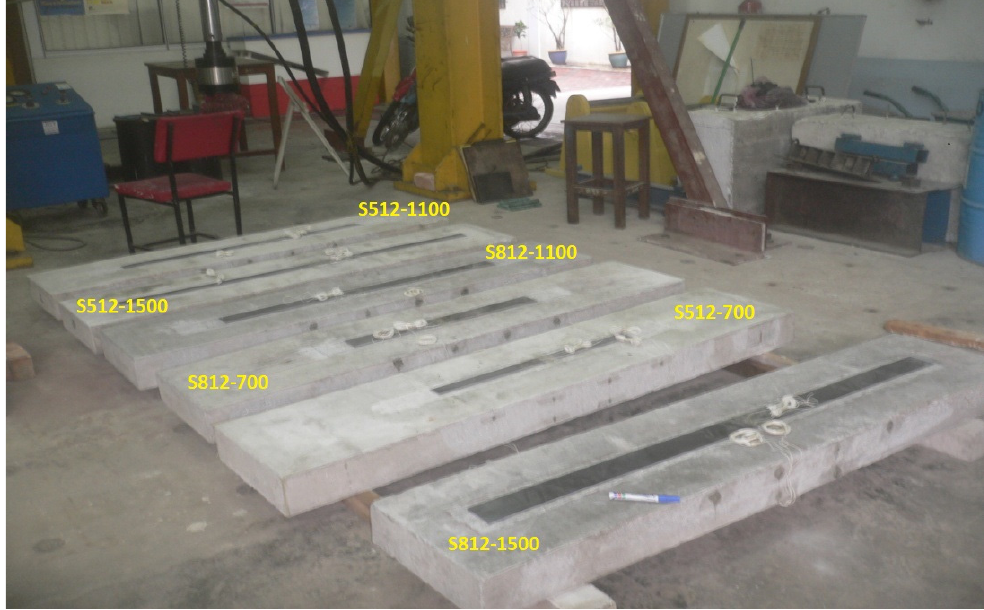
Figure 7. RC slabs strengthened with CFRPs of various lengths and widths.